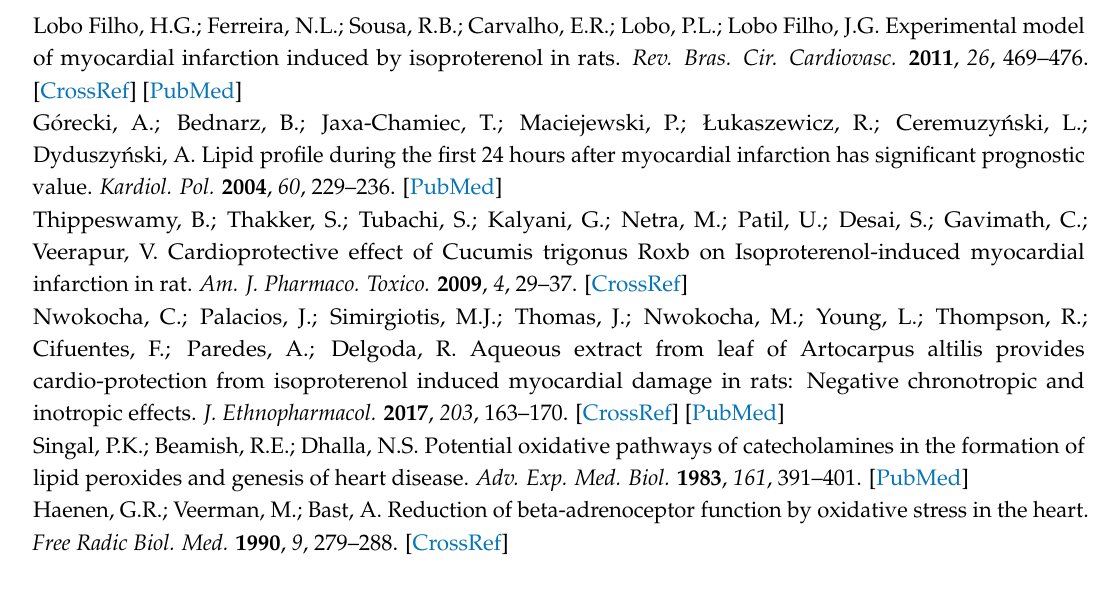
Supplementary Materials: The following are available online, Figure S1: Quadrupole Orbitrap full MS spectra and structures of all detected compounds in the fruits of Melicoccus bijugatus